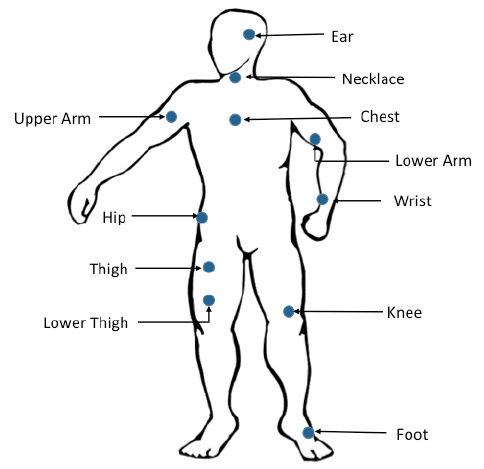
Figure 2. Graphical illustration of wearable sensor placement.